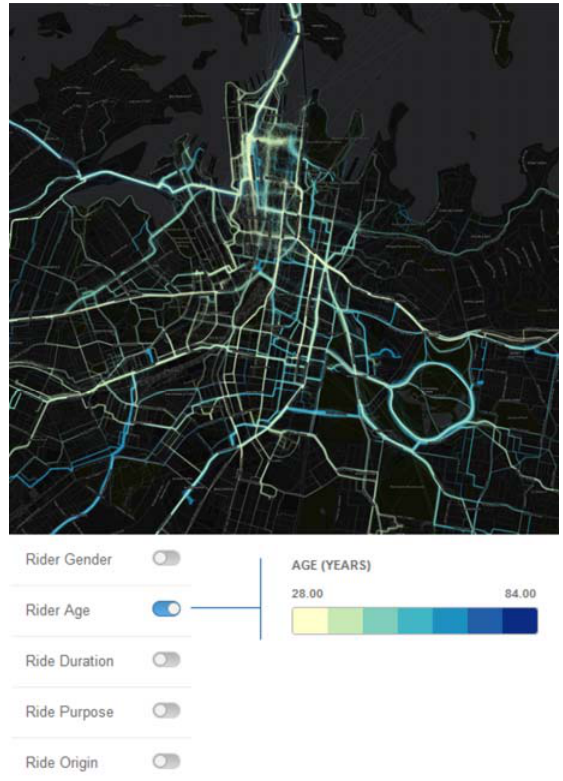
Figure 4. Sydney Area Routes by Rider Age